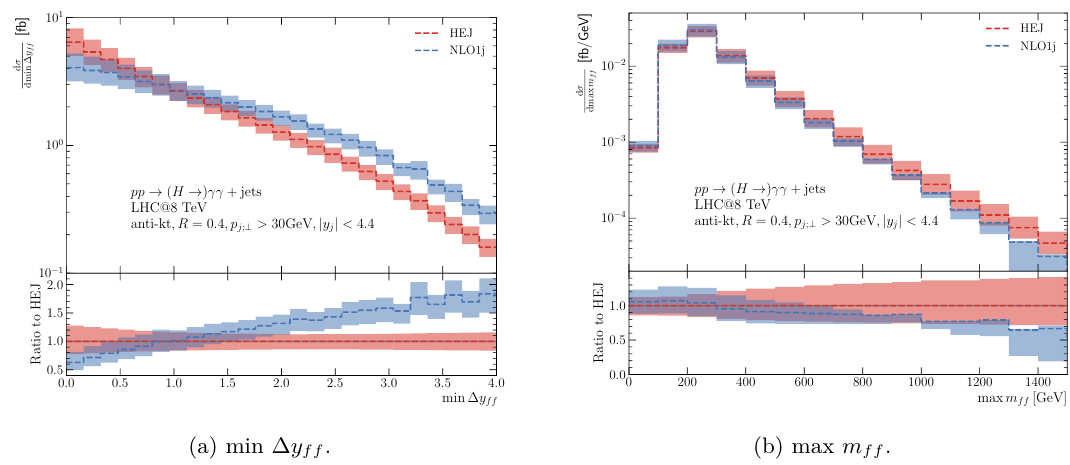
Figure 9. High-energy sensitive 1-jet distributions. (a): minimum rapidity separation between any two outgoing particles (Higgs boson or jets). (b): maximum invariant mass between any two outgoing particles (Higgs boson or jets). HEJ results are rescaled by the inclusive cross section ratio σ NLO1J /σ HEJ 1J